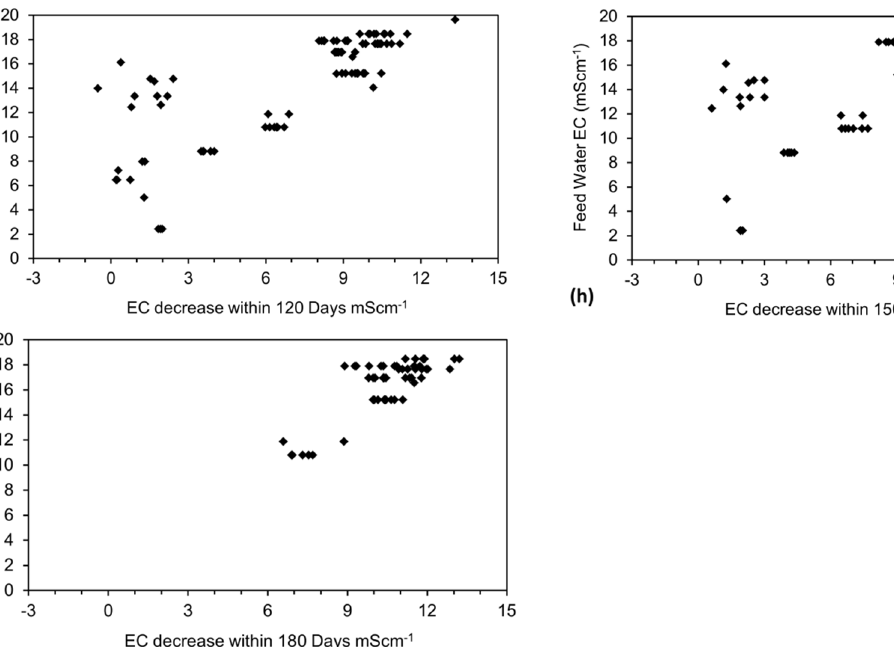
Figure 16. Statistical Trials: Relationship between EC change and the time interval which has lapsed following placement of the ZVM TP in the water. ( a ) Observed EC declines within 4 h; ( b ) ZVM TP concentrations associated with declines observed in a 4 h